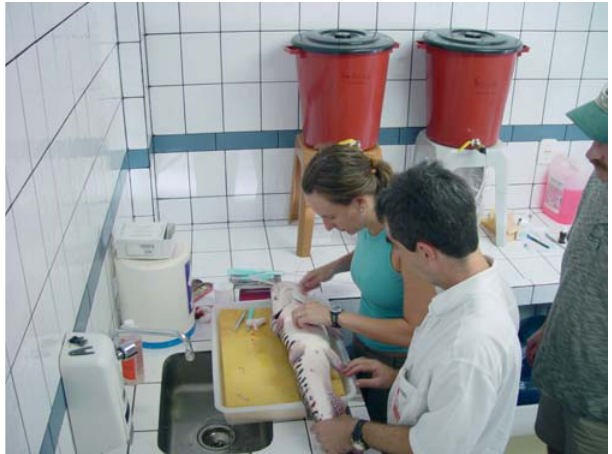
Fig. 2. Surgical implantation of a radiotransmitter in Pseudo- platystoma fasciatum , captured in the lateral channel located near Itaipu Dam.